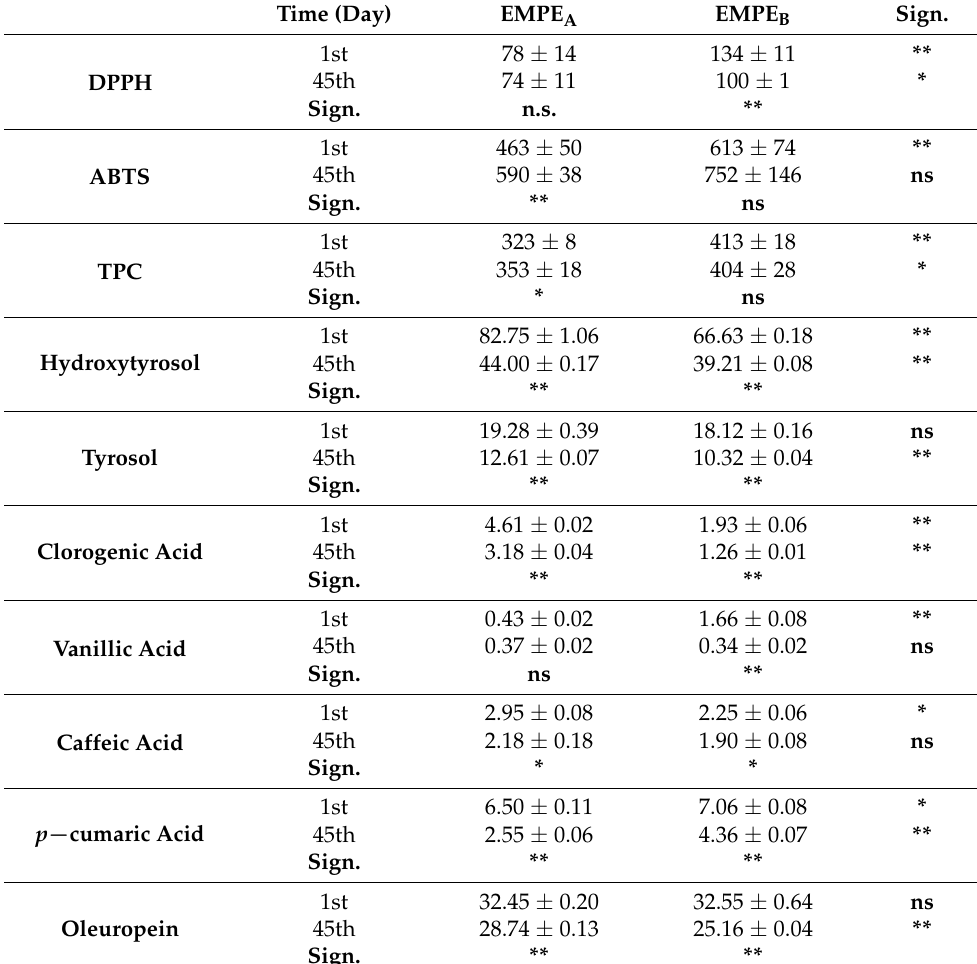
Table 3. Variation of the mayonnaise antioxidant parameters at 1st and 45th day of storage. Time